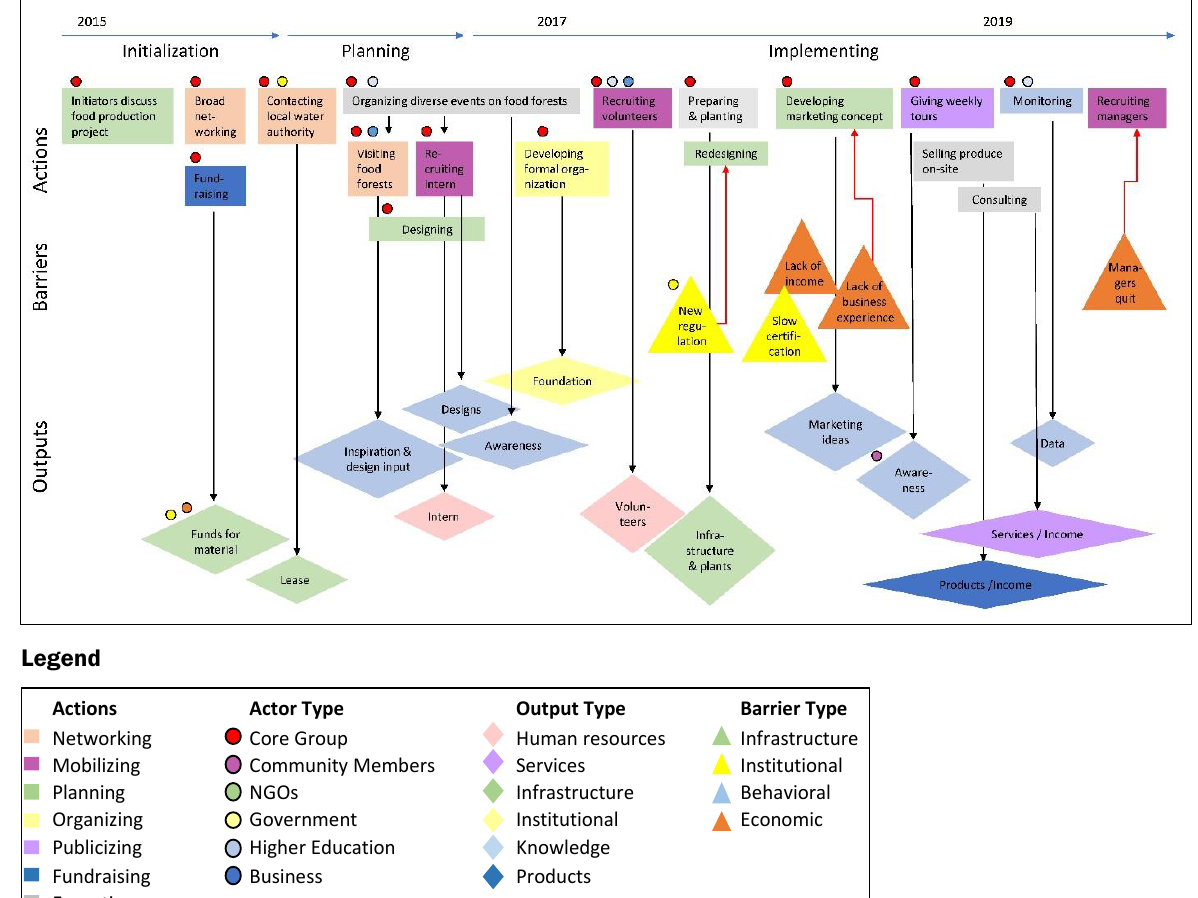
Figure 3. Implementation Path of Den Food Bosch, 2015 –